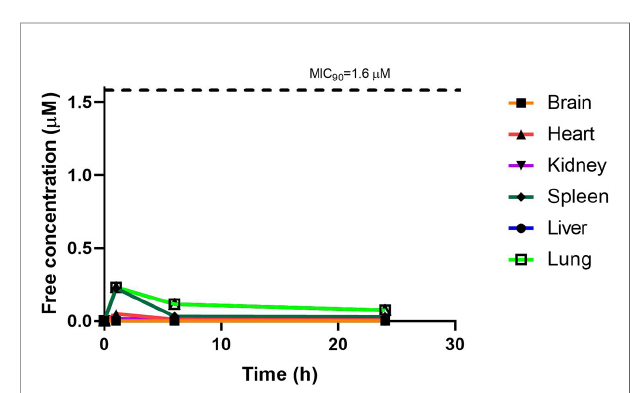
FIGURE 7 | Free concentration of RMB041 (µM) following correction according to tissue